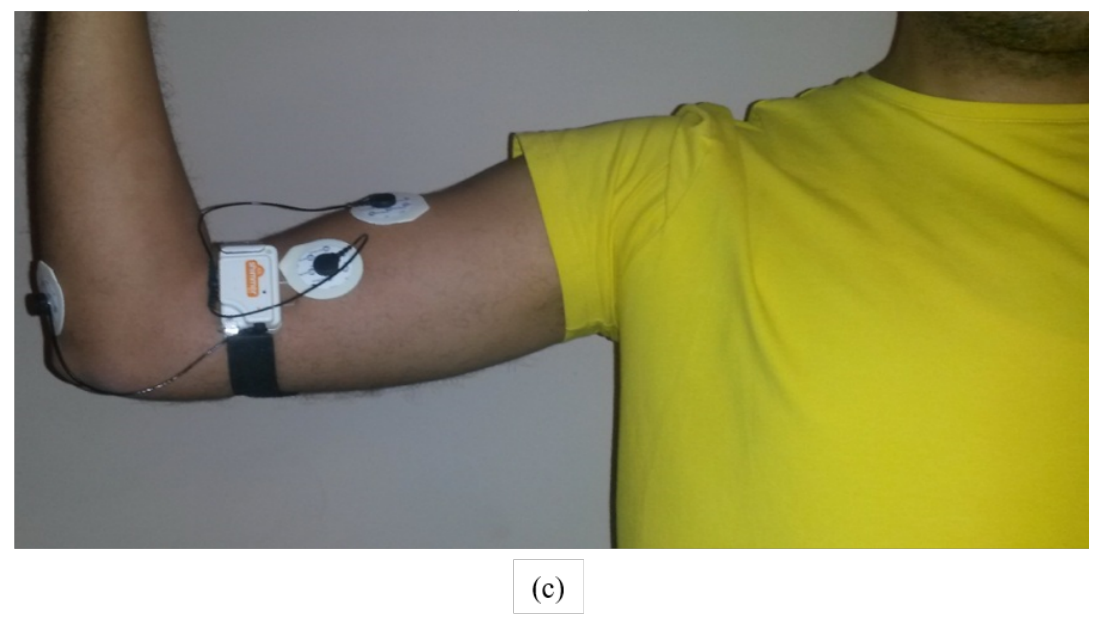
Figure 1. ( a ) Accelerometer sensor placement, ( b ) electromyography (EMG) sensor placement at forearm, ( c ) EMG sensor placement at Biceps.t, ( b ) EMG sensor placement at forearm and ( c ) EMG sensor placement at biceps brachii (BB) muscle.